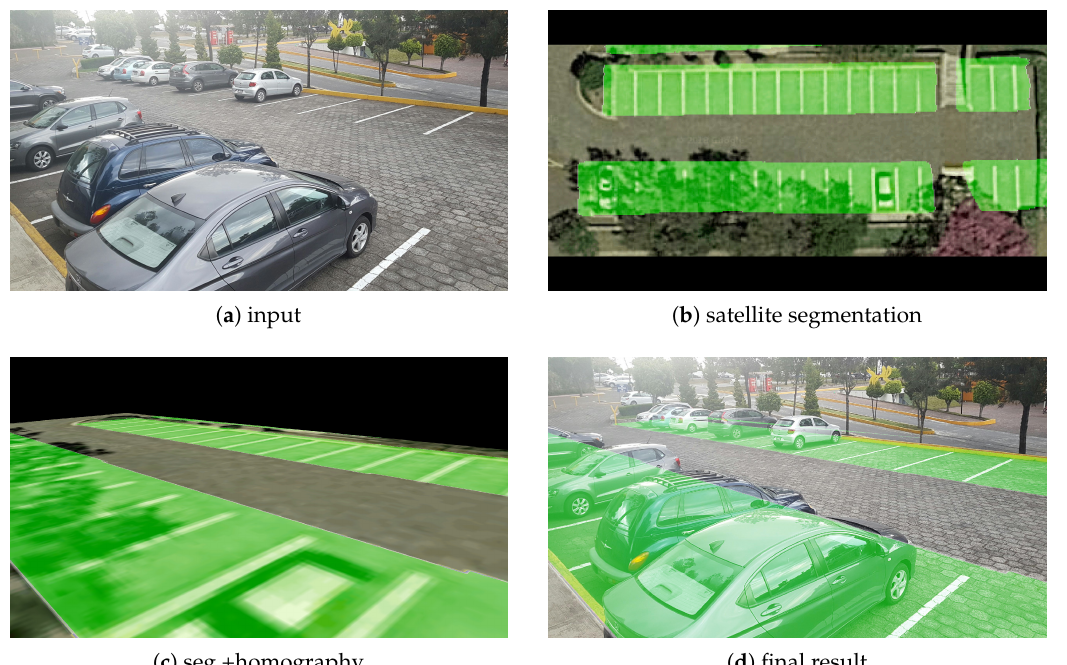
Figure 1. Segmented parking blocks despite several frequent vehicle occlusions from a surveillance camera